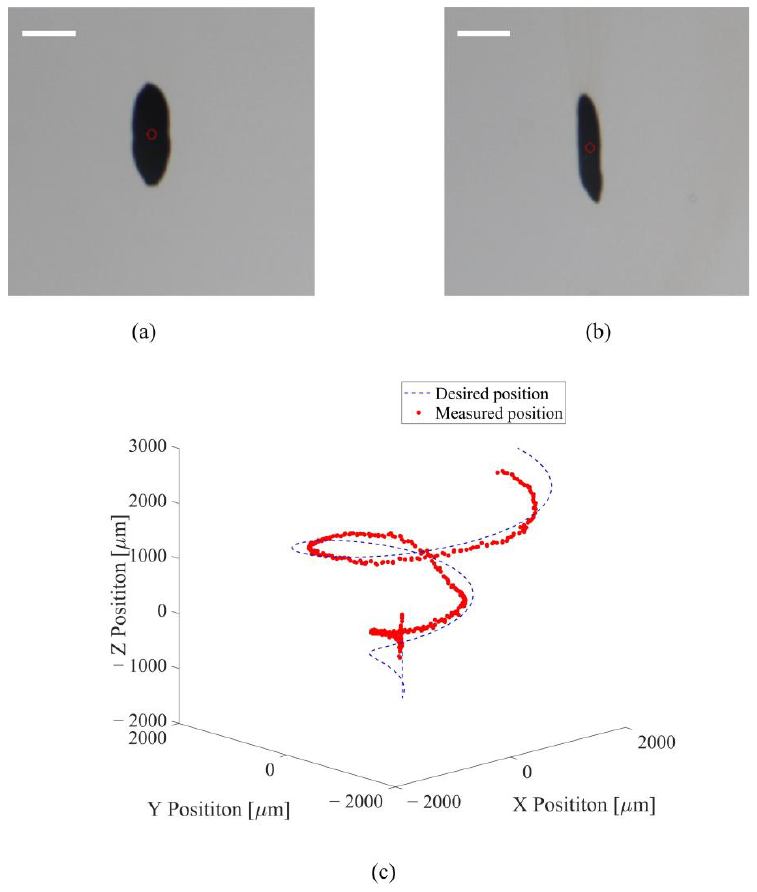
Figure 8. Demonstration of trapping and manipulating superparamagnetic iron oxide nanoparticles and polystyrene beads: ( a ) superparamagnetic iron oxide nanoparticles cluster was trapped in the O-XY plane view; ( b ) polystyrene beads cluster was trapped in the O-XY plane view; ( c ) manipulation of polystyrene beads cluster following helical trajectory (scale bar: 3 mm).